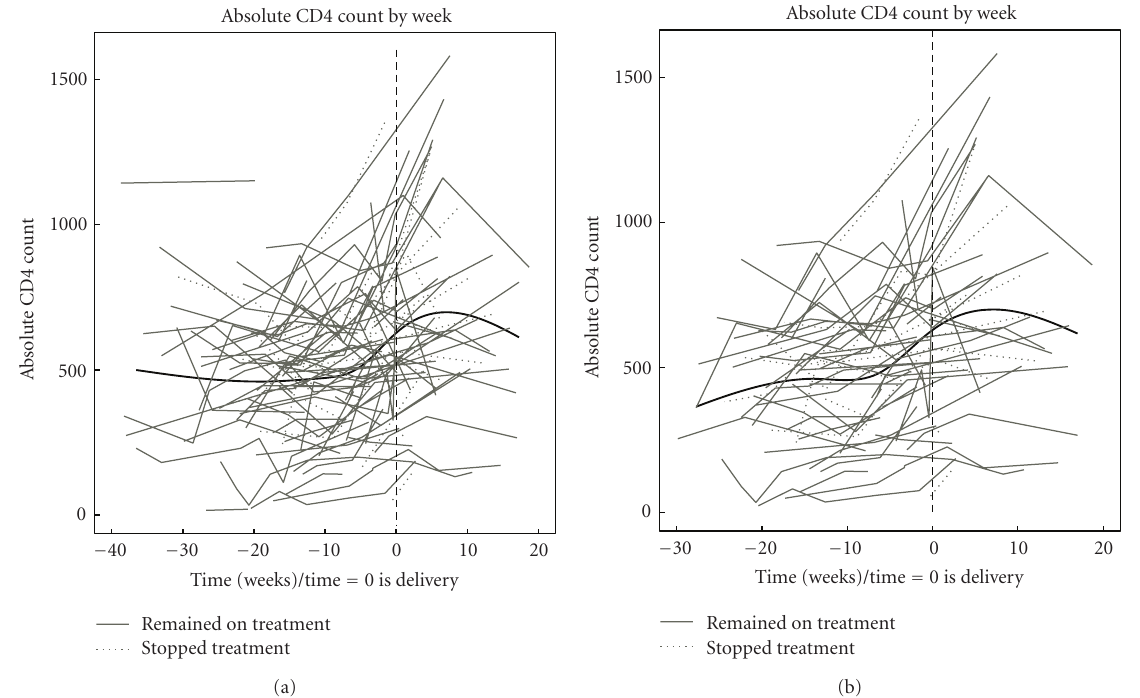
Figure 2: Kinetics of CD4+ counts in HIV-infected pregnant women on combination ARV. (a) Data were derived from 100 pregnant with available data who started therapy before or during pregnancy. (b) Data were derived from 76 pregnant women who started therapy during pregnancy after being o ff therapy for several months or never being on therapy. Time 0 indicates delivery. Grey lines represent individual CD4+ trajectories. The black line represents the population curve generated by the mixed-model analysis.